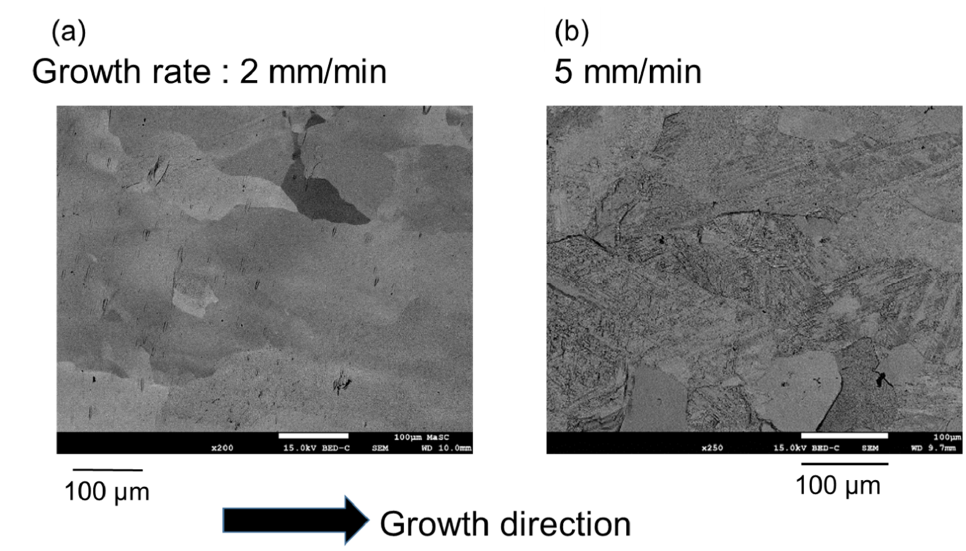
Figure 3. Scanning electron (SE) images on the cross-section polisher (CP) treated surfaces parallel to the growth direction for the Co-Cr-Mo fibers fabricated at ( a ) 2 mm / min and ( b ) 5 mm / min growth rates.